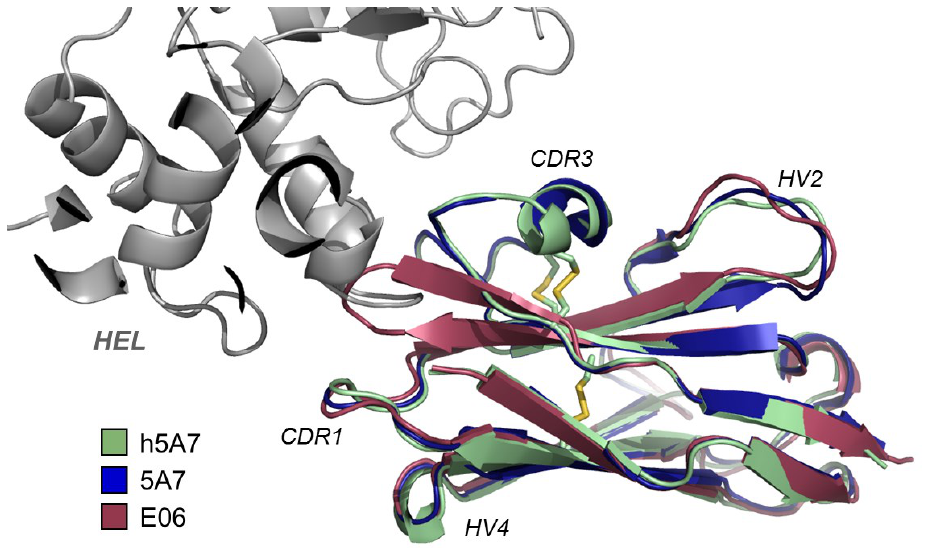
Figure 4. Humanized soloMER™ 5A7 (h5A7) and E06 superimposed onto a structural model based on 5A7 in complex with HEL